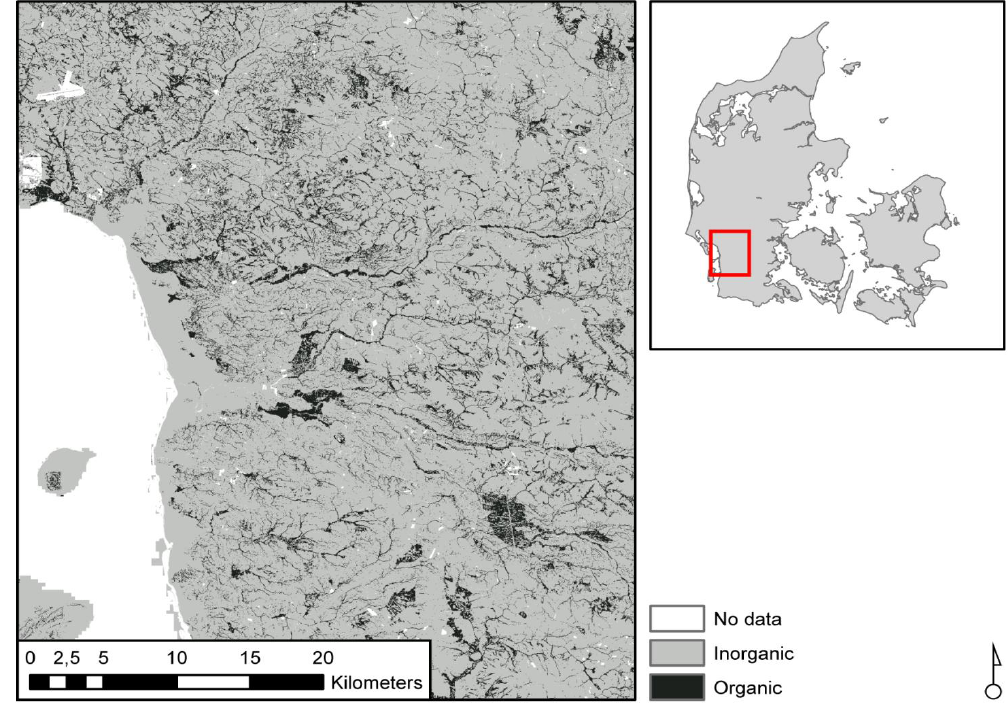
Figure 3. 30 Fig. 3. Map showing the distribution of hydromorphic organic landscapes in the chosen study area within Denmark.